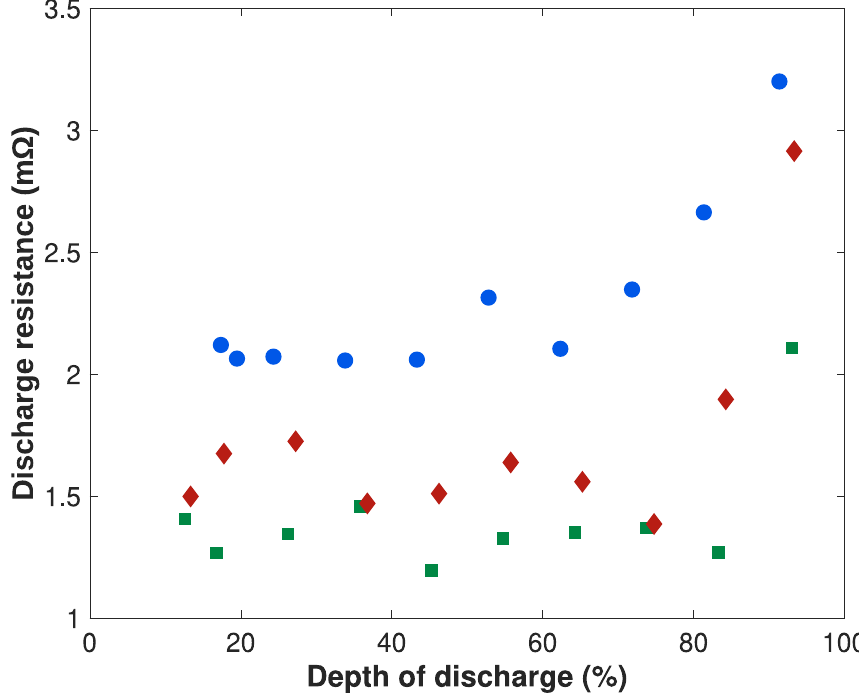
Figure 5. Discharge resistance of a second life cell at 0 (blue points), 25 (green squares) and 40 °C (red diamonds). Measurement is made at − 1C and a 5 s resistance is considered.